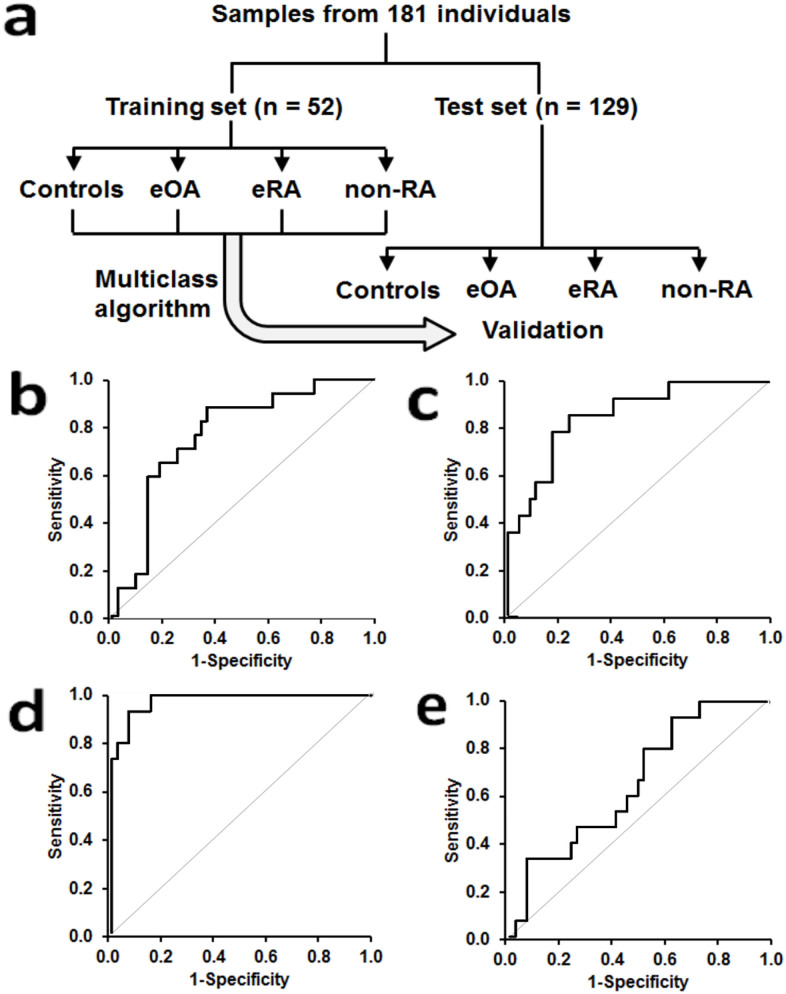
Training and validation of a multiclass algorithm for detection and discrimination of early stage osteoarthritis, rheumatoid arthritis, other inflammatory joint disease from healthy subjects.(a) Training set and test set study groups. Receiver operating characteristic curves in the test set for detection of: (b) healthy controls (n = 37), (c) eOA (n = 30), (d) eRA (n = 35) and (e) non-RA (n = 32).